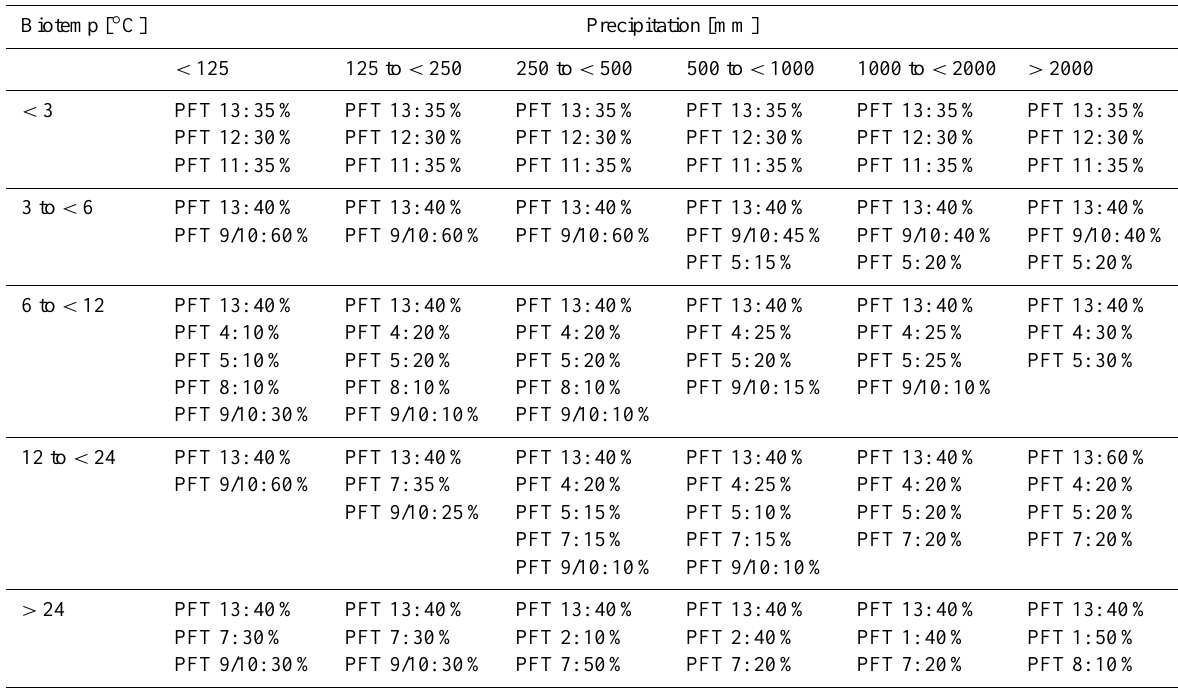
Table 3. Allocation of GLC2000 class mosaic vegetation (grassland/shrubland/forest) (50–70%)/cropland (20–50%) to PFTs according to the Holdridge ecosystem classes.